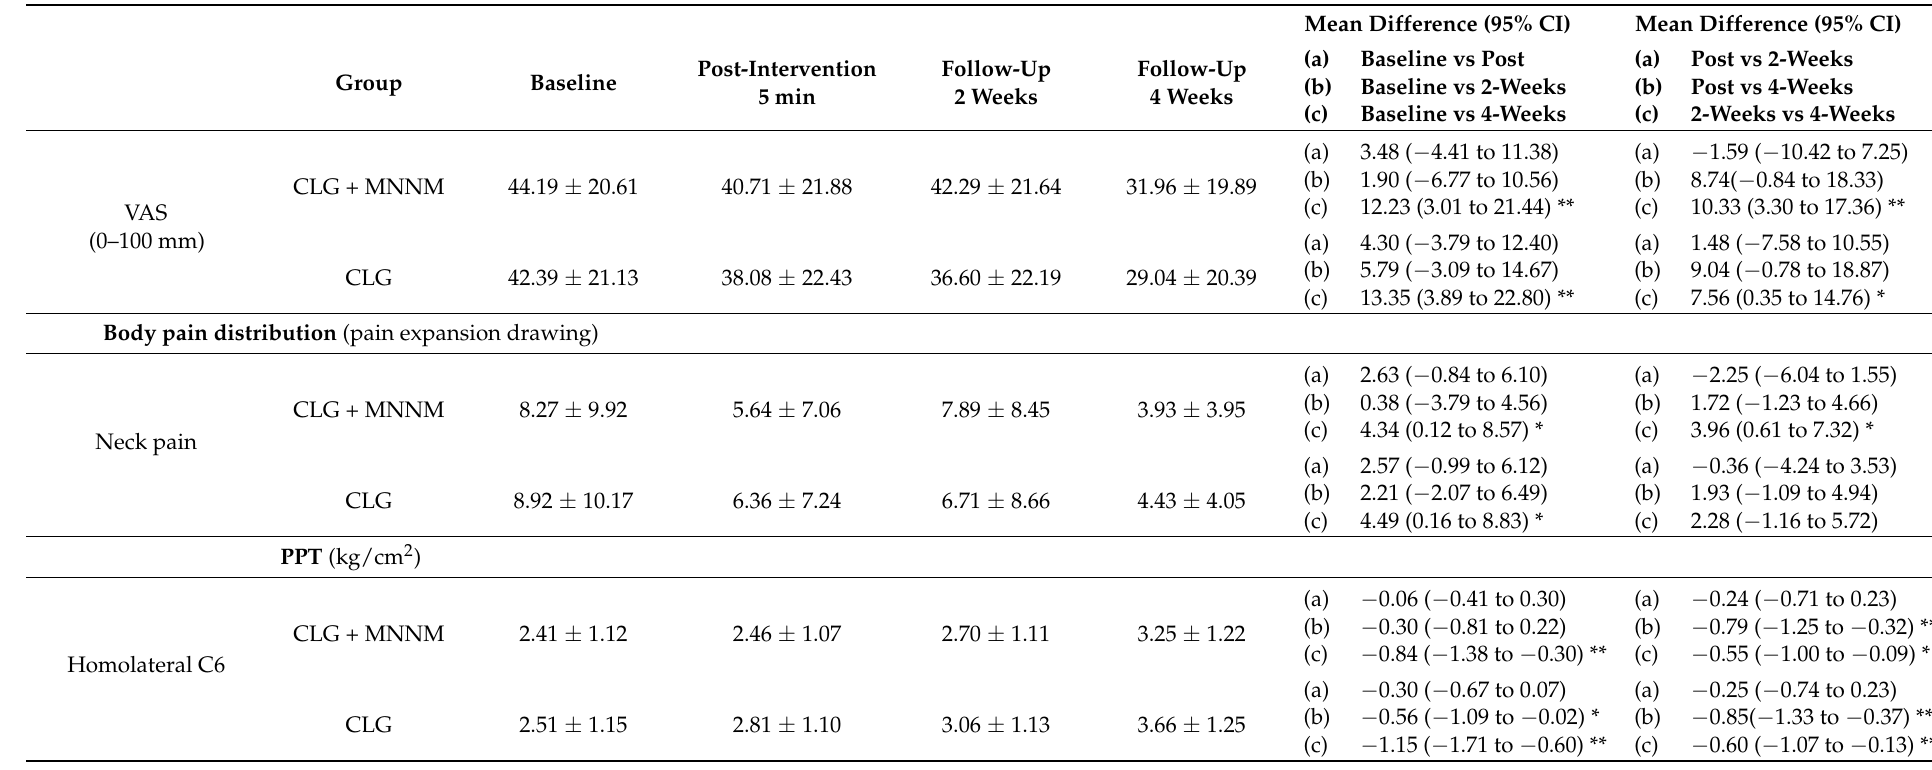
Table 3. Multiple comparisons for pain intensity, symptom distribution and pressure pain thresholds. Values are the mean ± standard deviation unless otherwise